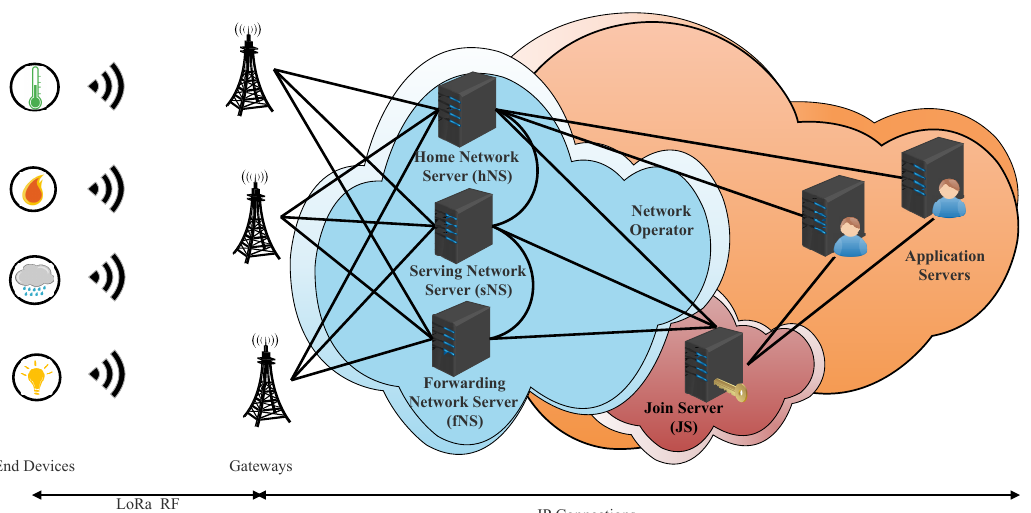
Figure 2. LoRaWAN v1.1